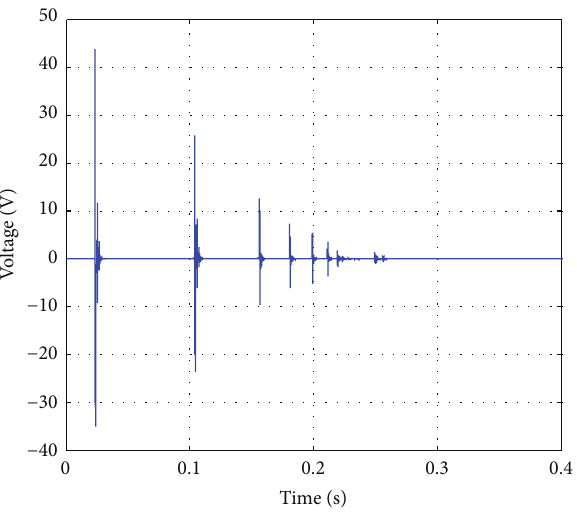
Figure 2: Example of the pulse signal.